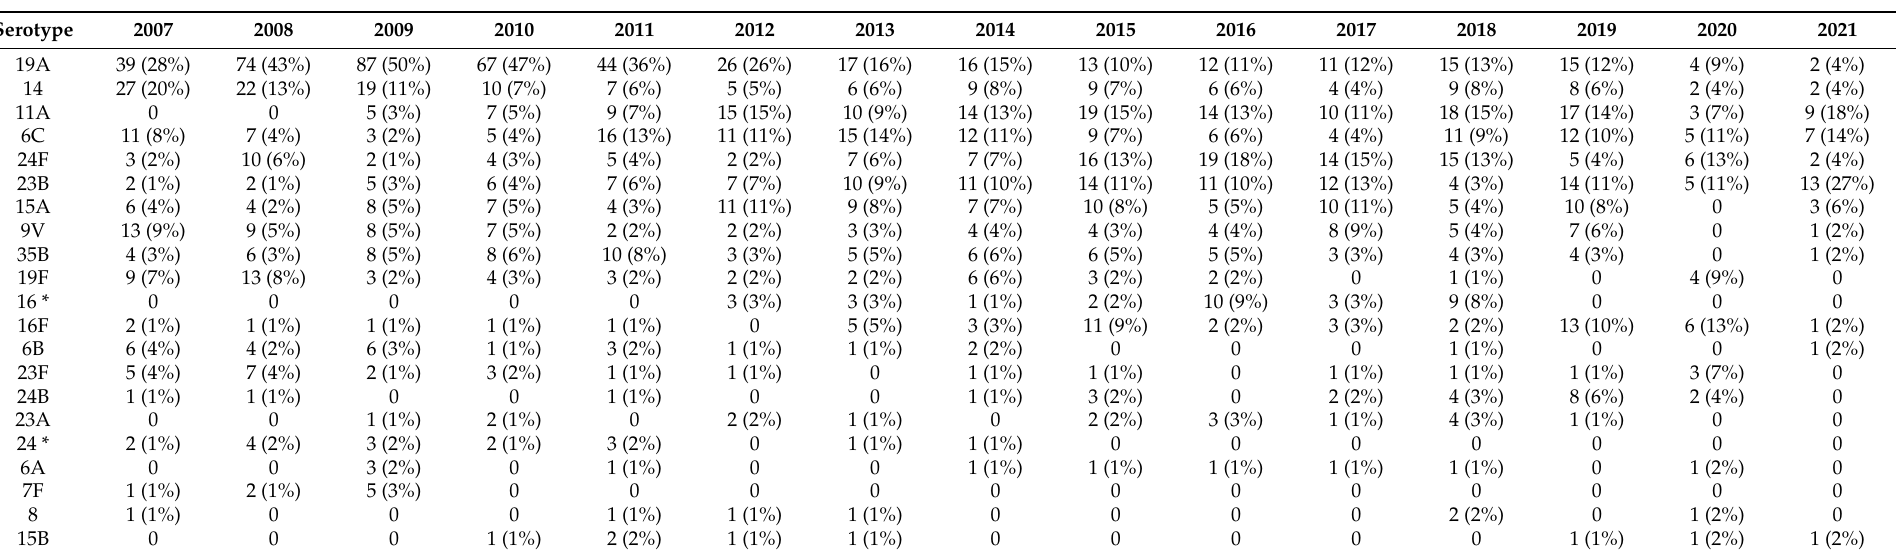
Table 4. Evolution of PNSSDR Streptococcus pneumoniae invasive strains (number and %) according to serotype (serotypes with ≥ 1% of the total PNSSDR